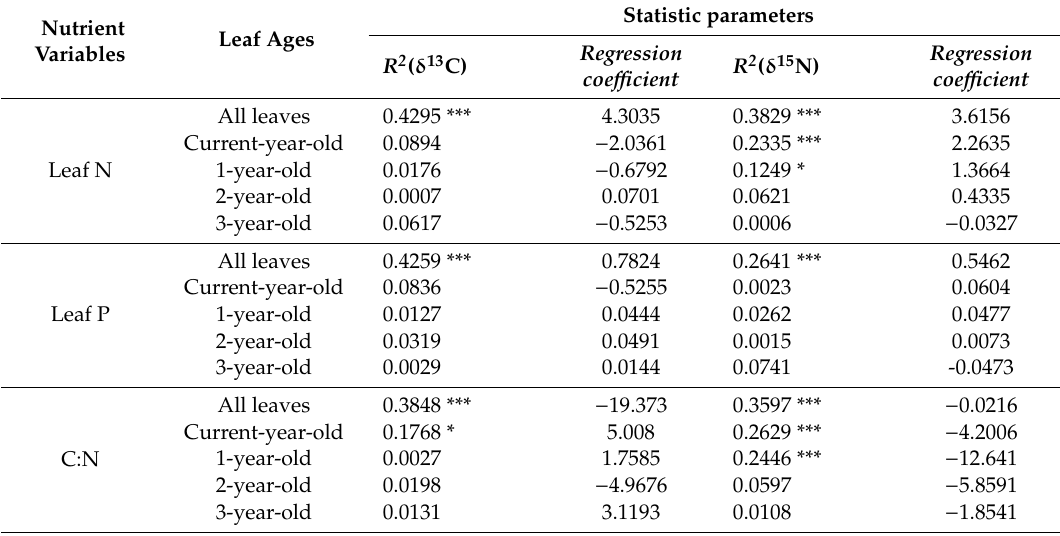
Table 2. Regression equations for leaf δ 13 C and δ 15 N values against leaf N and P concentrations and the C:N ratios for 4 years’